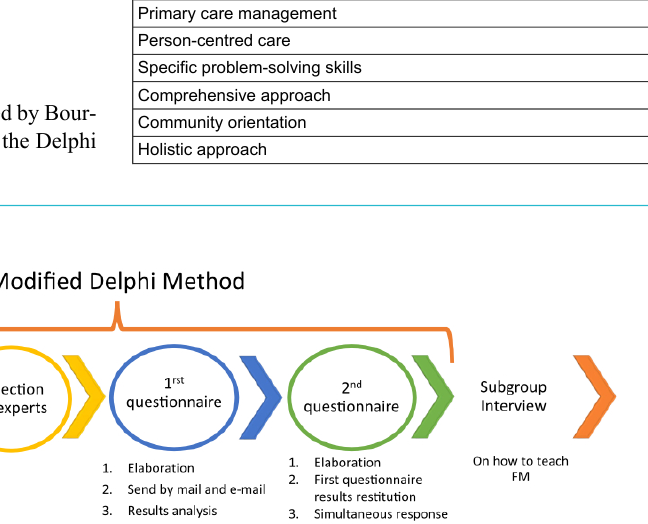
Table 1: The six core competencies of the family doctor according to the Euro- pean WONCA definition of family medicine [3, 4].